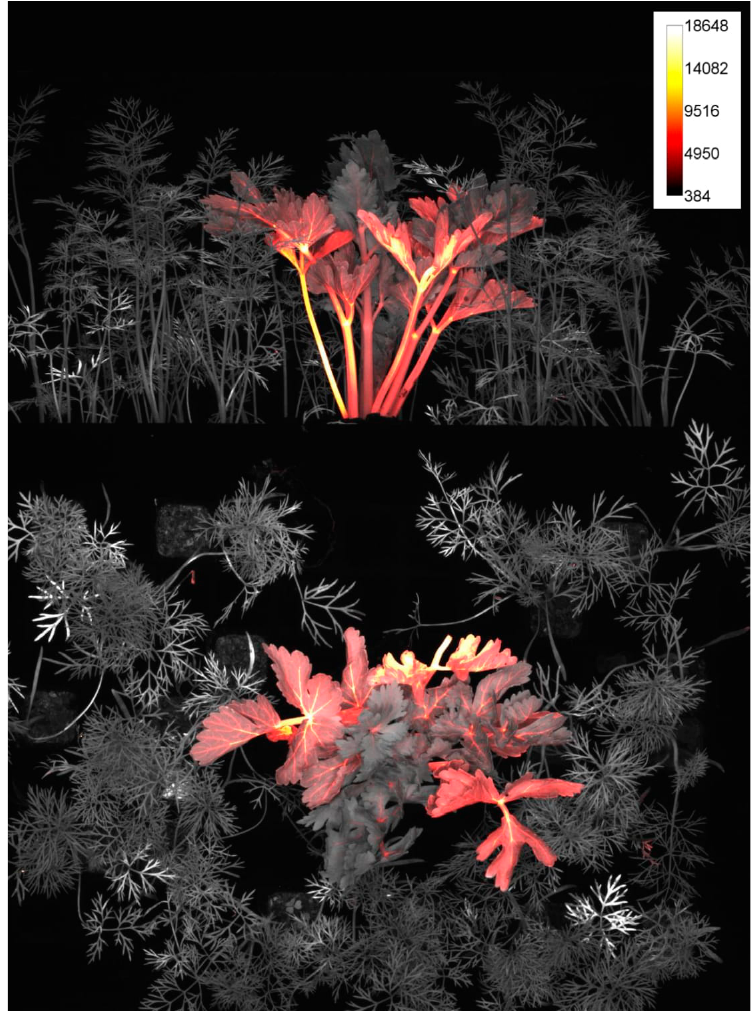
Figure 2. Pseudo-color images of Rh–B-treated celery grown under sunlight for about 4 weeks [53].